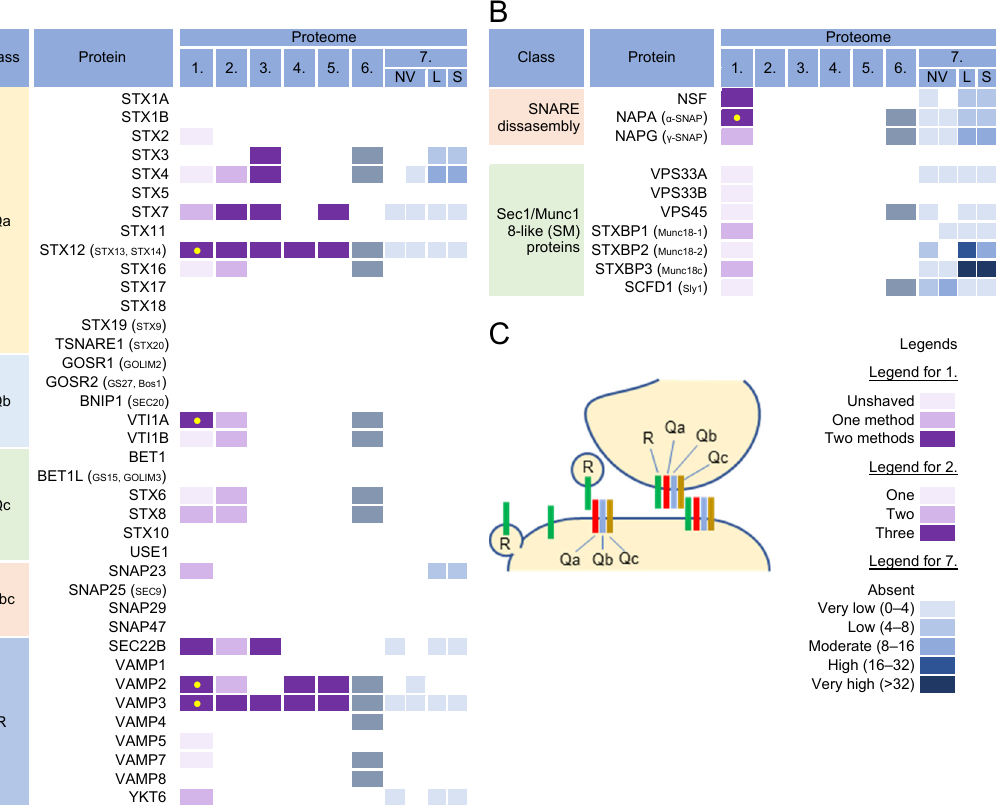
Figure 7. SNARE proteins and components of the SNARE disassembly machinery in virion and extracellular nanoparticle preparations. ( A ) SNARE proteins grouped based on their domain topol ‐ ogy [196] and their identification in five proteomes of HCMV virion preparations (proteomes 1–5); proteomes of HSV ‐ 1 heavy particles (proteome 6); and NVEP (NV), lEV (L), sEV (S) nanoparticles (proteome 7), as described in Figure 3. ( B ) Proteins that control and chaperone SNARE assembly [195] and disassembly, and their identification in proteomes of virions and extracellular nanoparticle preparations. ( C ) Principles of SNARE assembly during vesicle fusion with acceptor compart ‐ ment, homotypic membrane fusion, and development of outgoing carriers [195]. Legend for protein identification in proteomes 1, 2, and 7, as described in Figure 3.